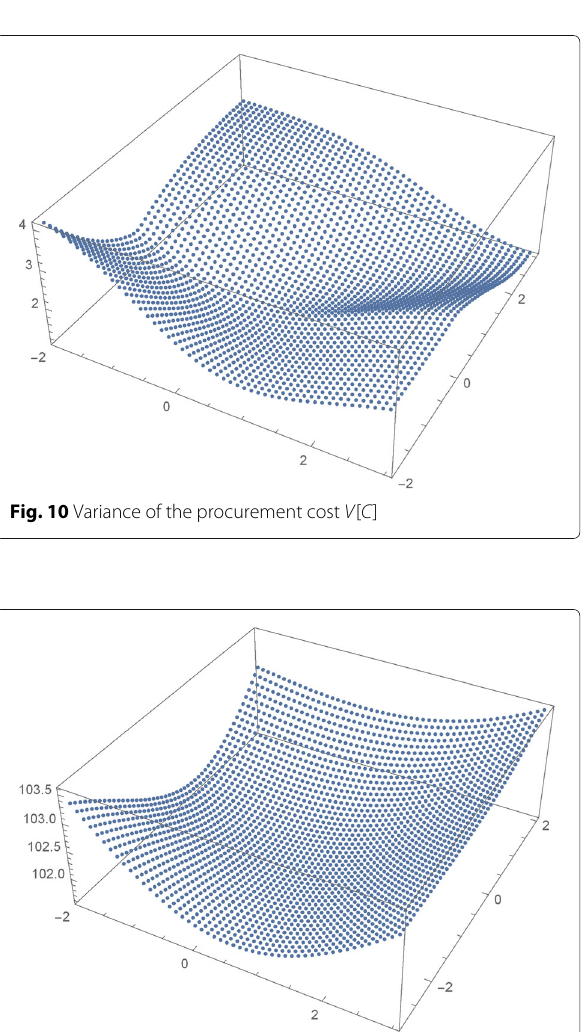
Fig. 11 Expectation value of the procurement cost E [ C ]